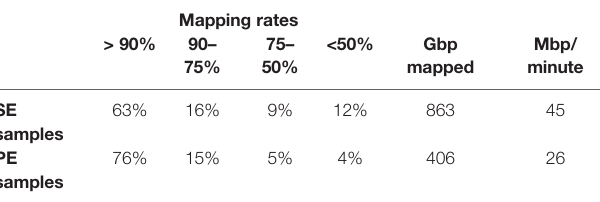
TABLE 2 | Mapping rates and time to completion for the example read mapping and transcript assembly (RMTA)